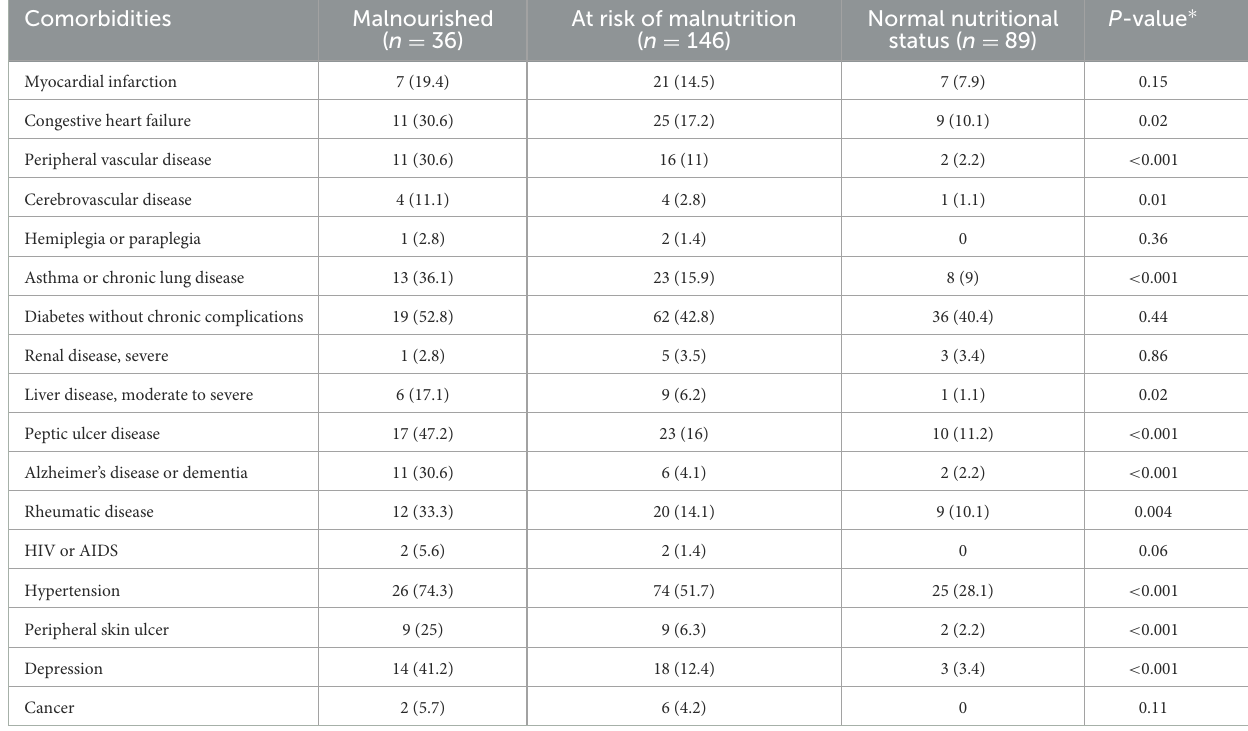
At risk of malnutrition ( n = 36) ( n = 146)